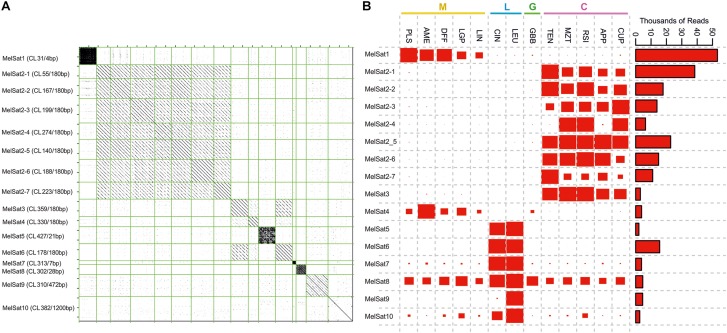
A comparison of satellite DNAs identified in the comparative analysis of all species analyzed in this study: (A) Dot-plot comparison of identified satellite DNA clusters (each represented by one contig) and (B) the contribution of reads from different species to each satellite DNA cluster. The area of red rectangles is proportional to the number of reads (abundance) contributed by each species. Color bars and capital letters above species names indicate the taxonomic series the species belong to (C, series Cupulata, pink; G, series Glabribracteata, green; L, series Leucantha, blue; M, series Melampodium, yellow).